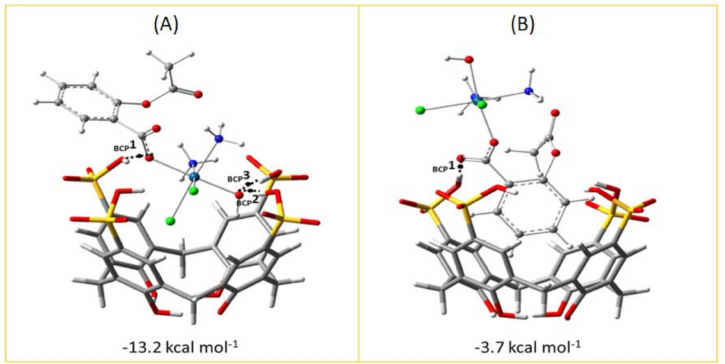
Figure 6. B97-D optimized geometry of the two most stable asplatin/PSC4 inclusion complexes along with the characterized BCPs and the free energy of inclusion values (kcal mol − 1 ). ( A ) The platinum center is included in the PSC4 cavity with the phenyl ring of the aspirinate ligand outside the larger rim. ( B ) The platinum center is located outside the PSC4 cavity, with the phenyl ring included